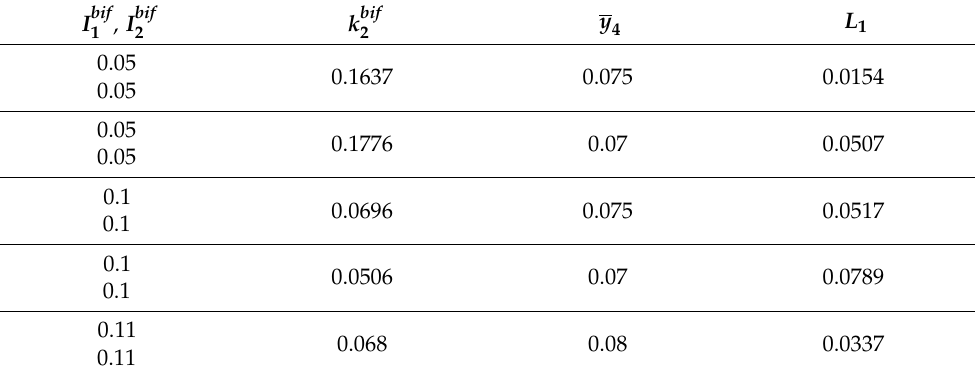
Table 1. Results for the first Lyapunov value ( L 1 ), at different bifurcation values of parameters k 2 , I 1 , I 2 and different equilibrium states y